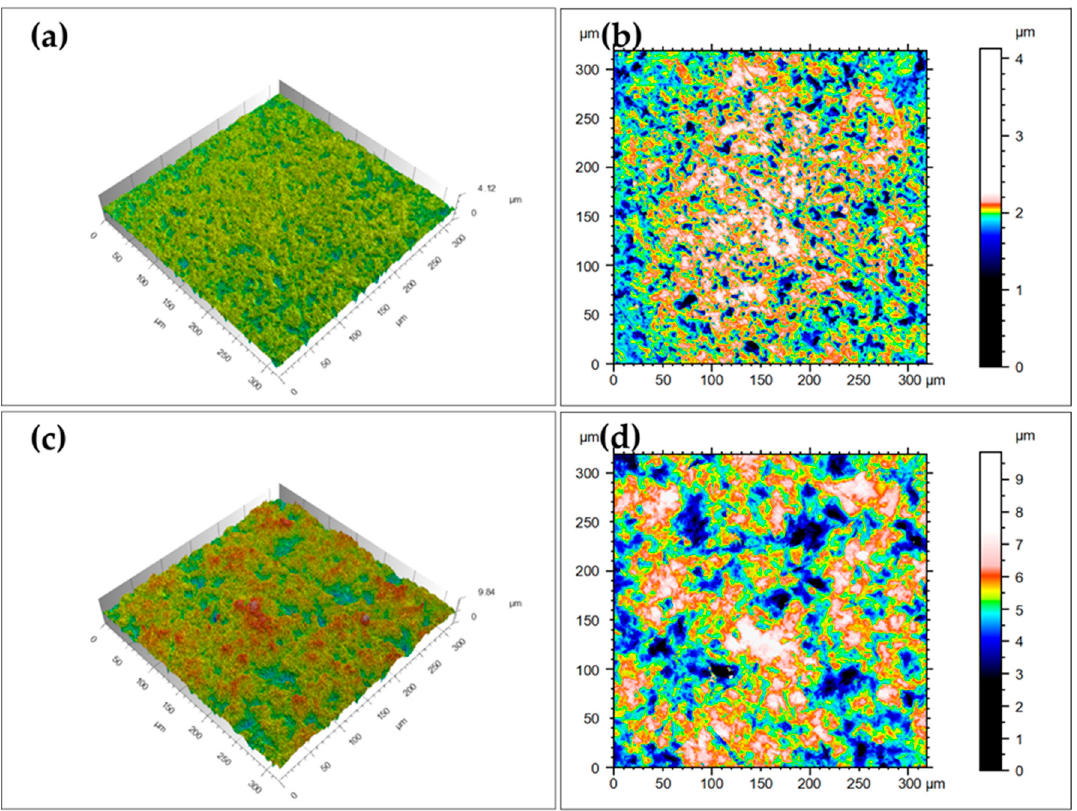
Figure 3. Confocal laser scanning microscope (CLSM) images of zirconia surface before ( a , b ) and after ( c , d ) the alumina sandblasting. The height difference is graded in colour ( b , d ).